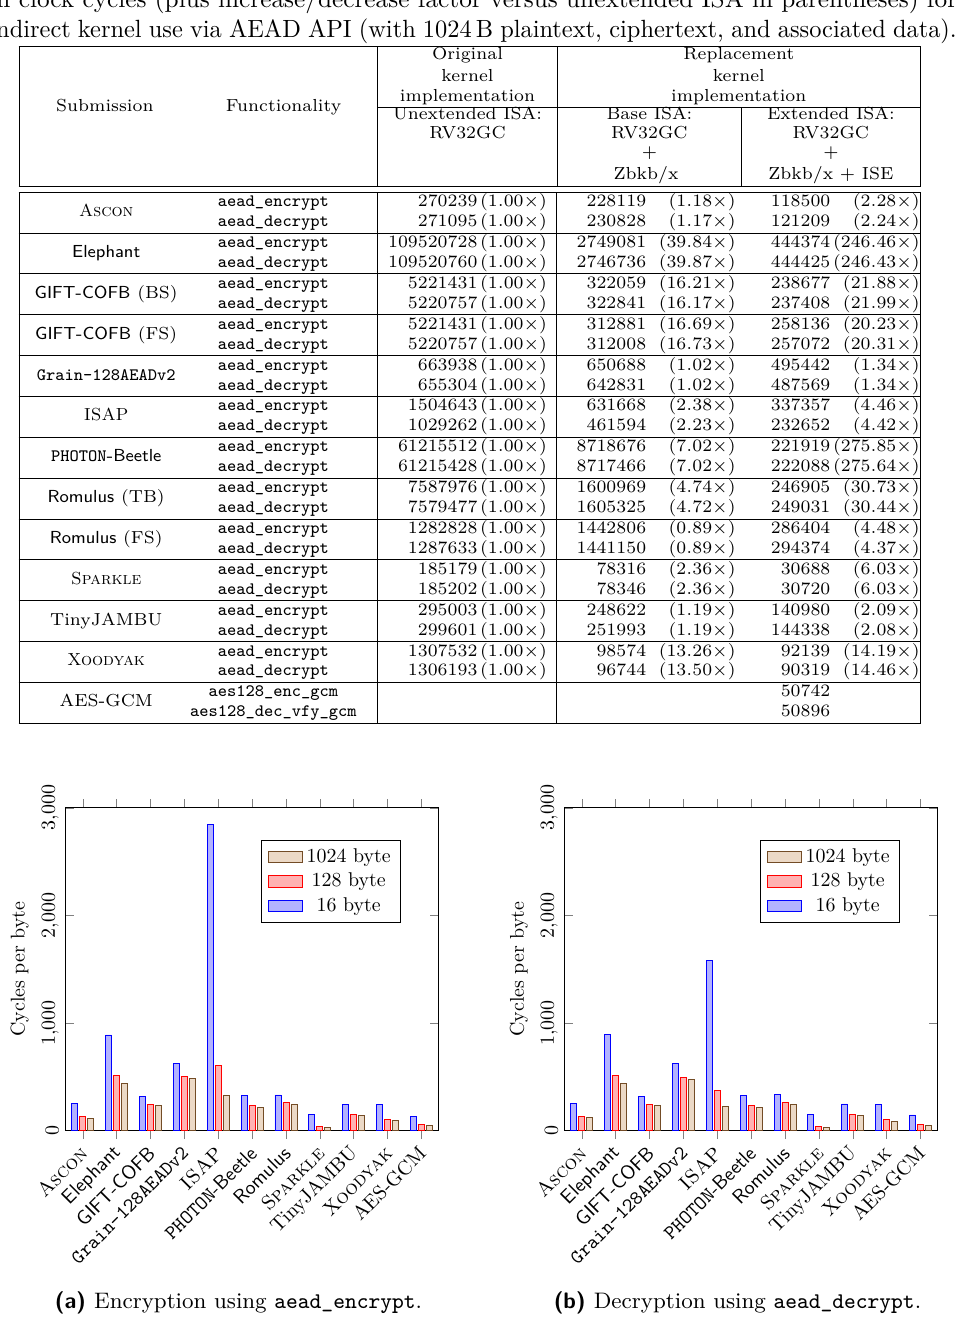
Figure 3: Two graphs summarising the data in Table 4, Table 5, and Table 6, with respect to encryption (left) and decryption (right): for each algorithm, we select the most efficient ISE variant (with respect to execution latency) and plot the normalised cycles per byte across all parameterisations considered (i.e., 16 B, 128 B, and 1024 B plaintext, ciphertext, and associated